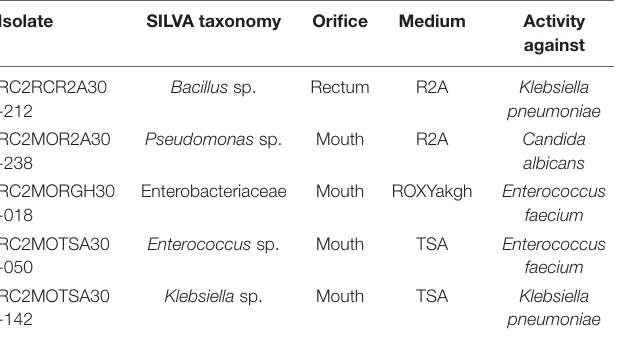
TABLE 2 | Cultivated bioactive isolates.